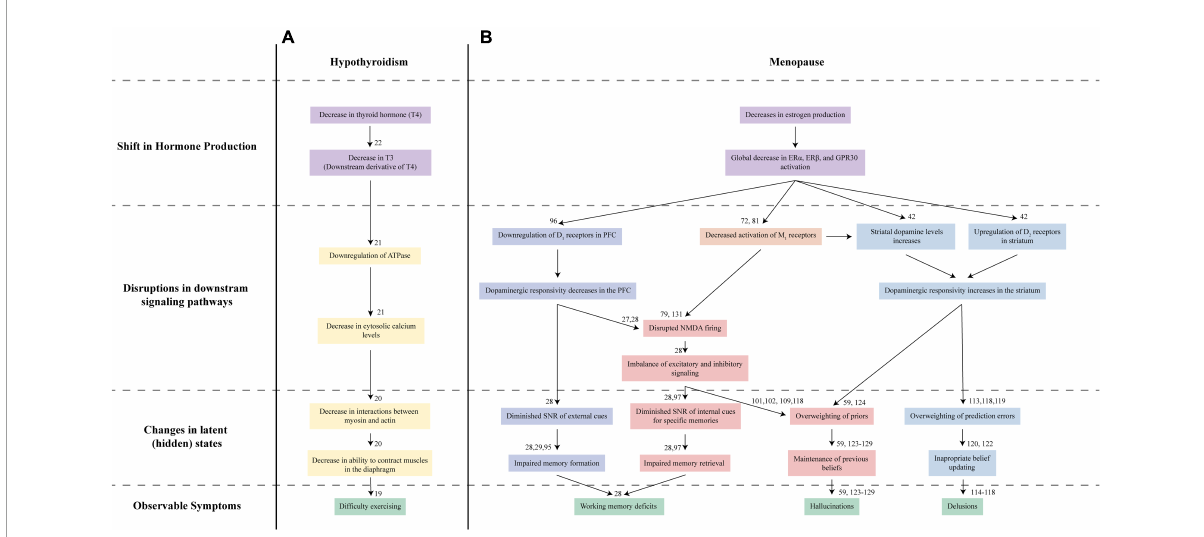
FIGURE1 Proposed Nosology of Estrogen-Mediated Psychosis. Understanding hypothyroidism-mediated exercise difficulties (A) and MAP (B) requires looking at multiple levels of changes. (A) In hypothyroidism, the initial decrease in thyroid hormone T4 (purple) and its derivative T3 leads to a series of disruptions in the downstream signaling pathways (yellow). These disruptions ultimately lead to impaired global muscle contractions in the diaphragm resulting in symptoms like irregular breathing and difficulty exercising (green). (B) Our proposed mechanism for MAP reflects this multilevel approach to understanding disorders. Diminished estrogen (purple) signaling in the brain affects bottom-up (blue) and top-down (red/orange) mechanisms that contribute to the latent states driving working memory issues, hallucinations, and delusions (green) characteristic of psychosis. Estrogen decline may disrupt signaling across several pathways: dopaminergic D 1 receptor activation in the prefrontal cortex (dark blue), D 2 receptor activation in the striatum (light blue), cholinergic M 1 activation (orange), and glutamatergic NMDA receptor activation (red). Disruptions to these symptoms, in turn, lead to altered latent states, driving psychosis